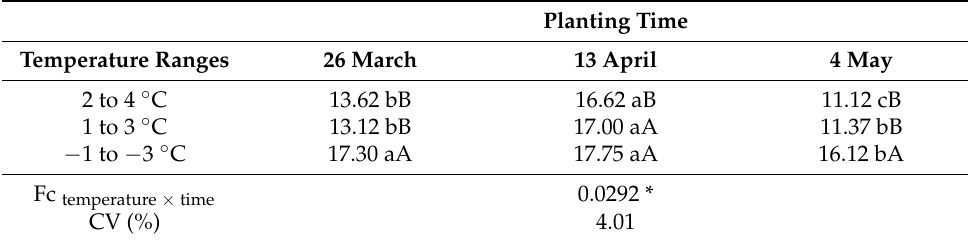
Table 8. Total productivity (t ha − 1 ) of garlic plants, Ito variety, under different temperatures ranges and planting